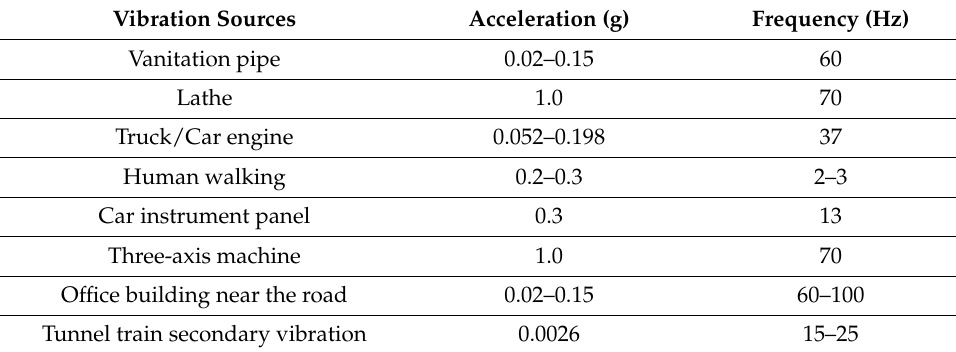
Table 2. Common vibration sources